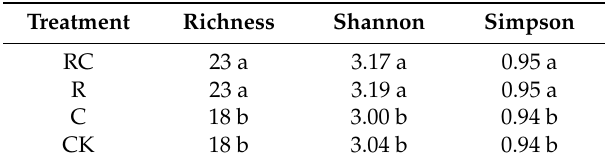
Table 3. Effects of rice straw and biochar on soil microbial diversity.